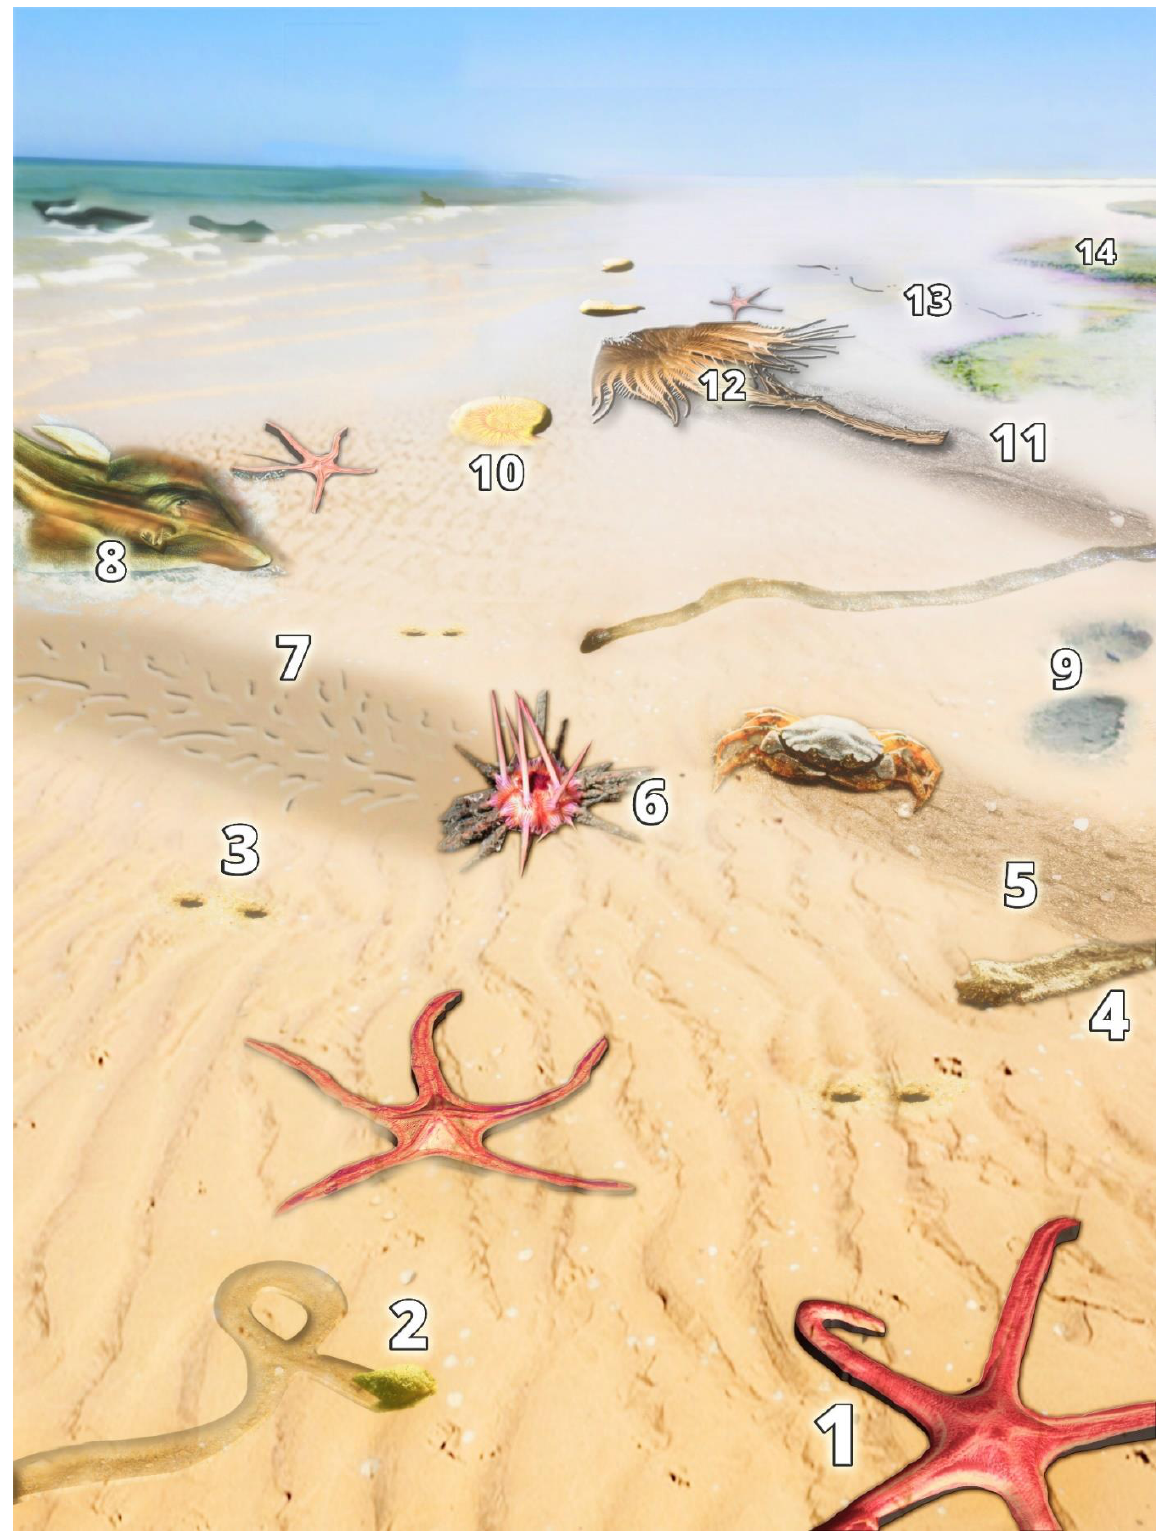
Figure 10. Reconstruction of the Cabeço da Ladeira tidal flat ecology based on the remarkable record of body and trace fossils of early? Bajocian age. Body fossils and biogenic structures represented: (1) Starfish including Noviaster ; (2) pleumotomarid gastropod; (3) Arenicolites, crustacean burrow; (4) Archaeonassa, gastropod trail; (5) Laterigradus lusitanica, crab trackway; (6) cidaroid; (7) cidaroid track; (8) guitarfish; (9) Piscichnus , ray feeding burrow; (10) lithoceratid ammonite; (11) Krinodromus bentou , crinoid trail; (12) isocrinid crinoid; (13) Undichna , fish trackway; (14) microbial mat.